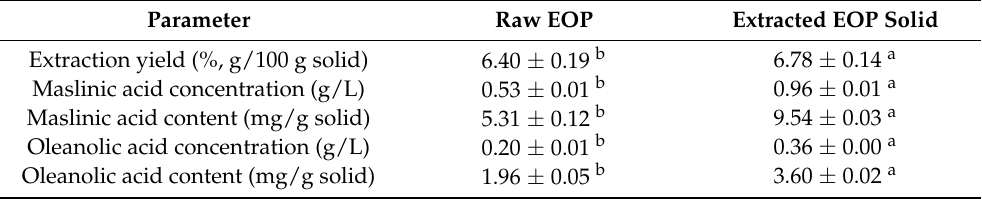
Table 5. Triterpenic acids extracted from the milled raw exhausted olive pomace (EOP) and extracted EOP solid obtained by microwave-assisted water extraction at optimal conditions (12% w / v , 100 ◦ C, and 16